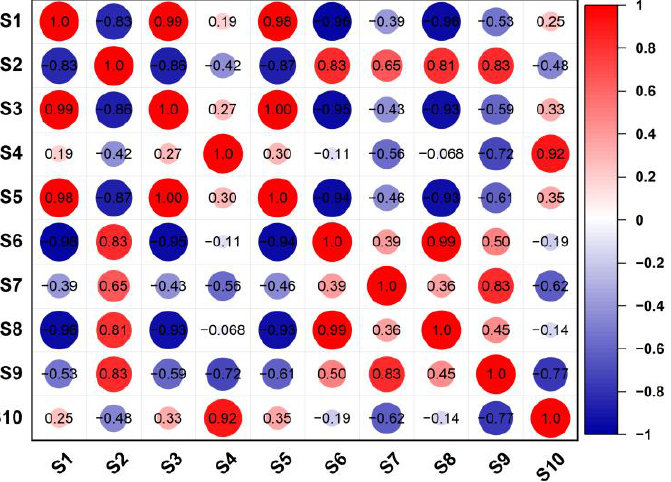
Figure 3. Sensor signal correlations based on Spearman’s correlations. The color scale denotes the correlations, with 1 indicating a positive correlation (red) and − 1 indicating a negative correlation